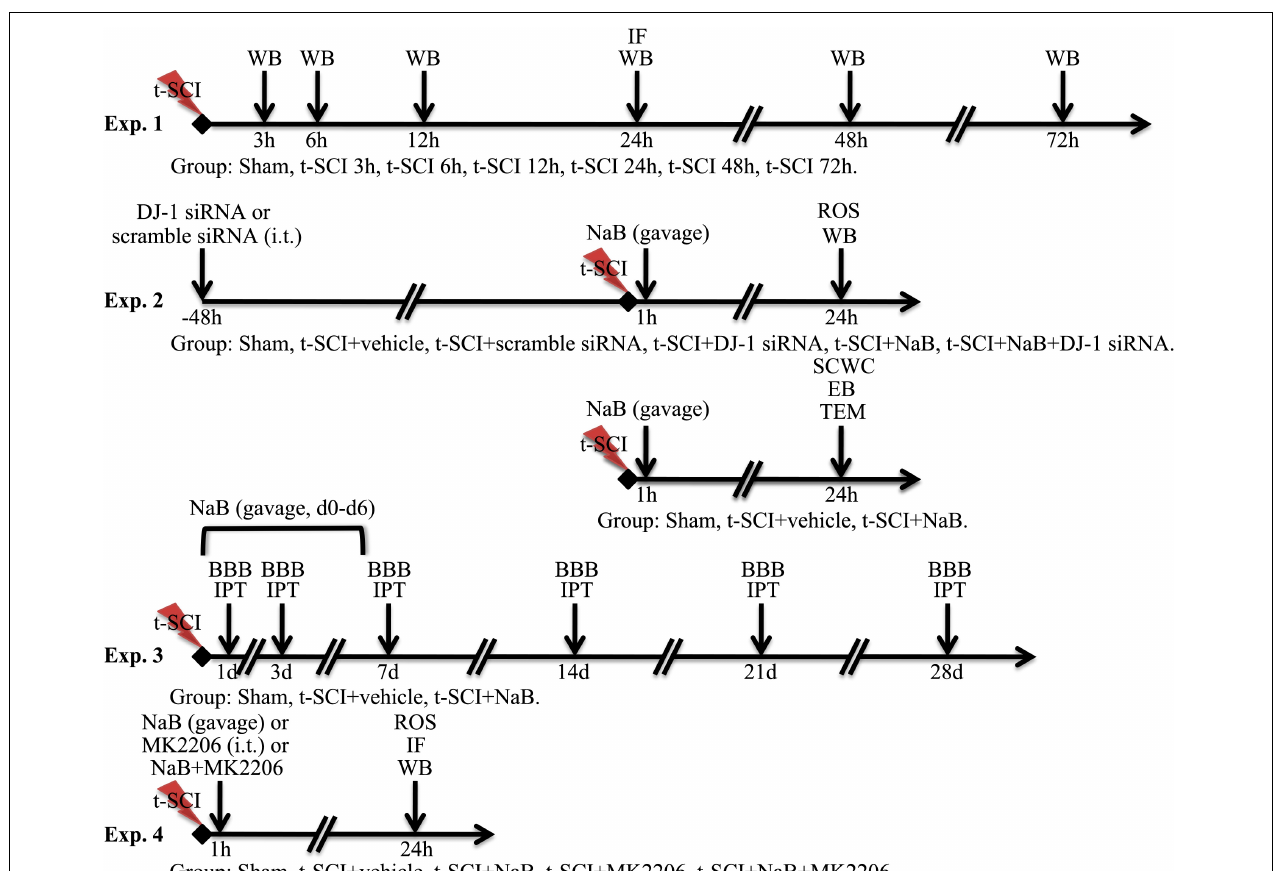
FIGURE 1 | Detailed experimental